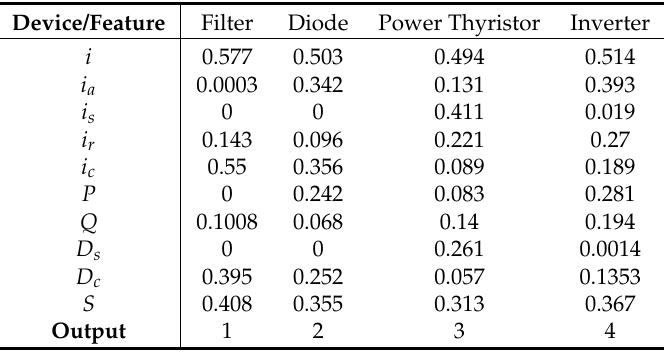
Table 1. CPC features for the chosen tested Devices